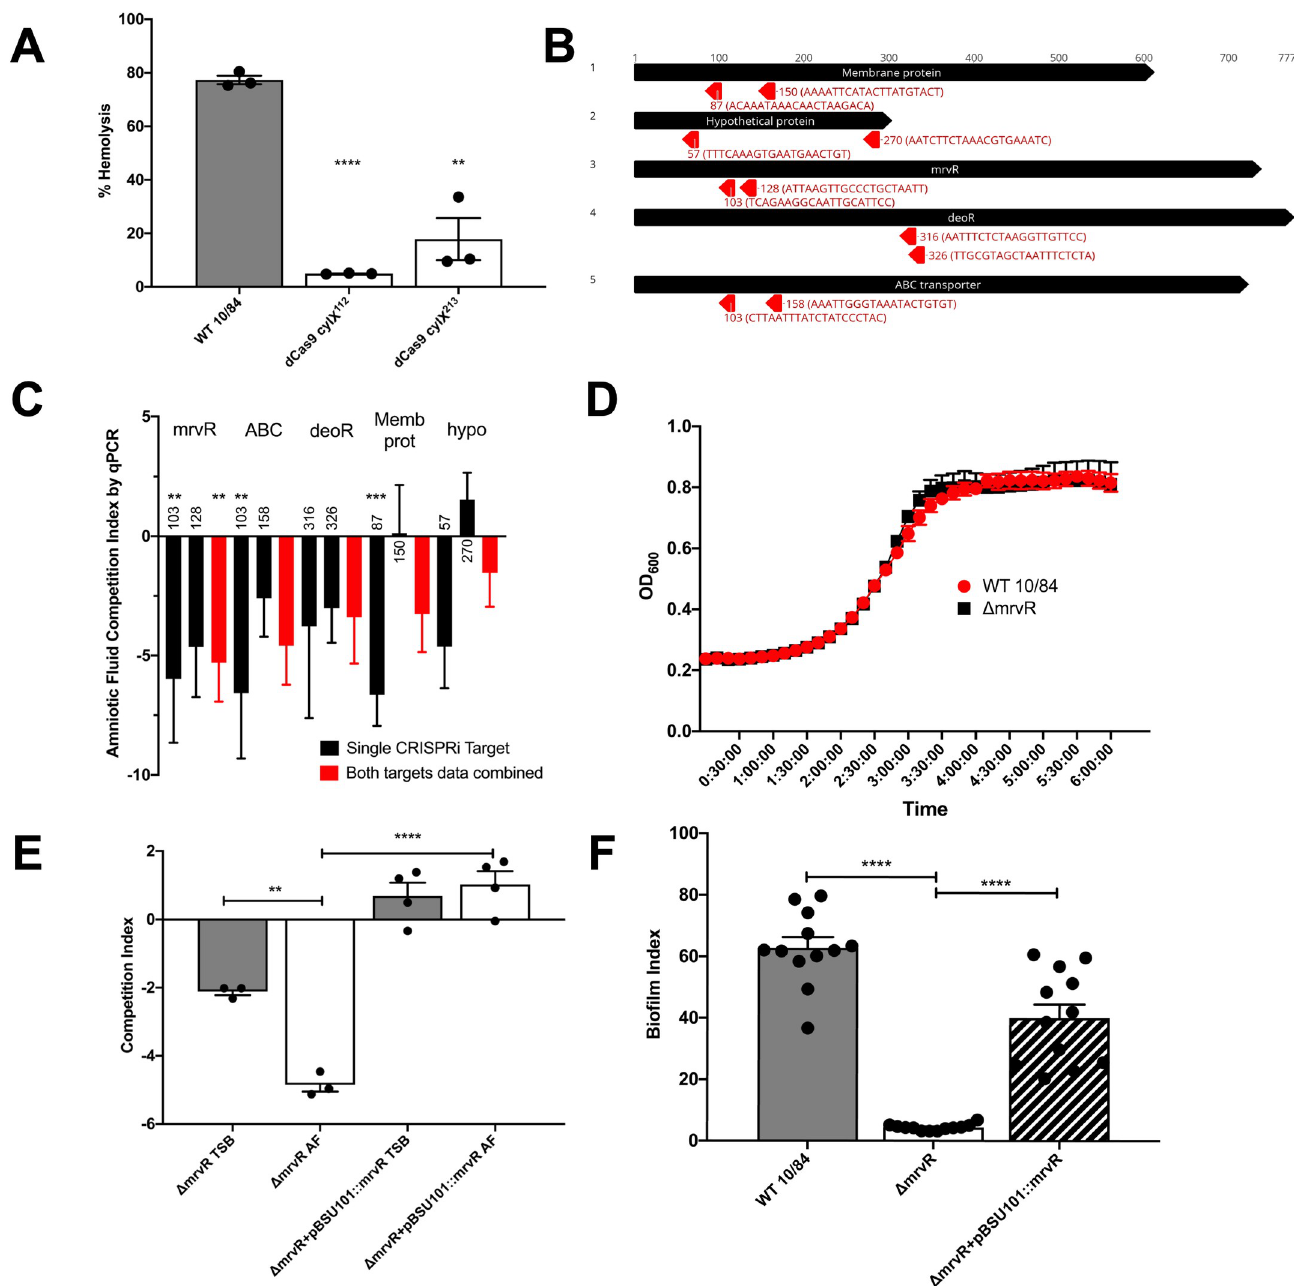
Fig 2. CRISPRi knockdowns of candidate genes and phenotypic characterization of GBS lacking MrvR in amniotic fluid, rich media, and biofilm-promoting growth conditions. Two CRISPRi targeting protospacers (targeting nucleotides 112 and 213 of cylx , the first gene in the operon) against the cyl operon were developed to knockdown expression of β -hemolysin/cytolysin. The resultant knockdown strains (in a 10/84 background) were compared to wild type in a human erythrocyte hemolysis assay ( A ). Targeting protospacers against the five candidate conditionally essential genes from amniotic fluid Tn-seq. For each gene, the number indicates the targeted nucleotide; the protospacer sequence is shown in parentheses ( B ). A qPCR-based multiplex CRISPRi screen using knockdowns of all five candidate genes revealed decreased fitness in amniotic fluid compared to tryptic soy (TS) broth ( C ); black columns show the competition index of strains bearing individual targeting protospacer plasmids, while red columns show pooled results from both targeting plasmids for each gene. Statistical significance of each knockdown phenotype was determined relative to growth of the knockdowns in TS broth. Growth curves of the Δ mrvR and wild type (WT) 10/84 in broth ( D ). Colony forming unit enumeration-based competition assays between Δ mrvR and Δ mrvR +pBSU101:: mrvR in TS broth (TSB) and amniotic fluid (AF); E ). Biofilm assay results comparing WT 10/84, Δ mrvR , and Δ mrvR +pBSU101:: mrvR . ( � p < 0.05, �� p < 0.01, ��� p < 0.005, ���� p < 0.001; t test, error bars show standard error surrounding